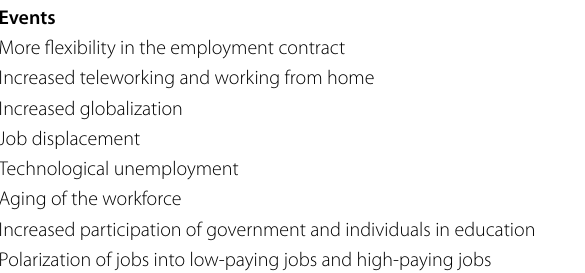
Table 3 Results for the brainstorming method for the employment